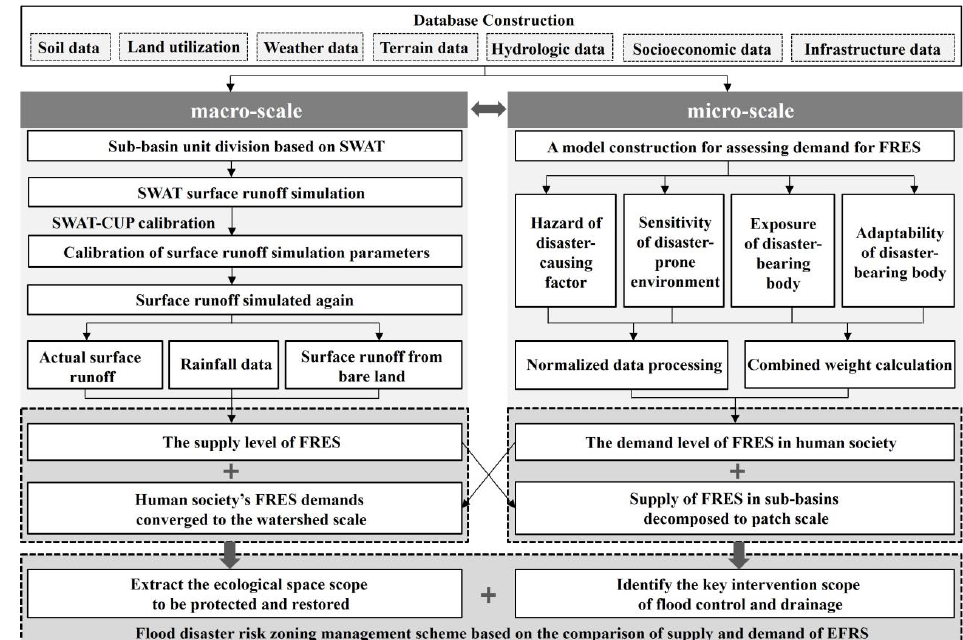
Figure 2. Research framework and technical